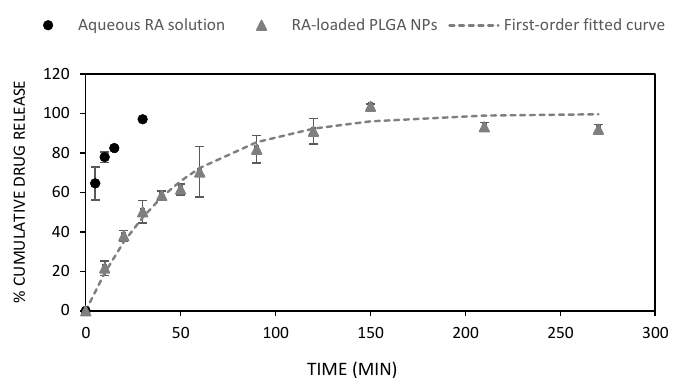
Figure 2. Drug release profile of RA-loaded PLGA NPs (grey dots) under physiological conditions (pH 7.4, 37 °C) using 1X PBS as receptor solution. The diffusion of free RA (black dots) was studied as a control experiment. First-order kinetic model ( r 2 = 0.992) fitted cumulative percentage of RA released from PLGA NPs (dashed line). Data correspond to the mean of three independent experi- ments.